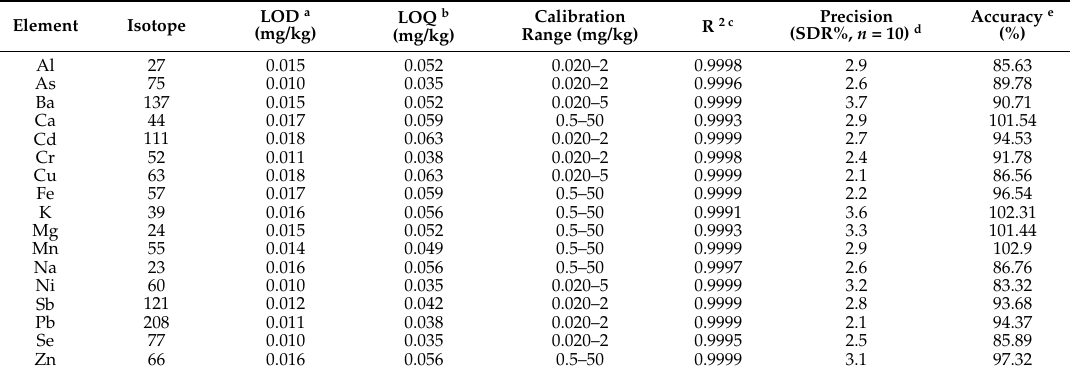
Table 3. Analytical performance of the method.